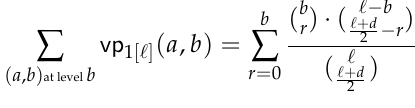
Figure 5. The values # of Figure